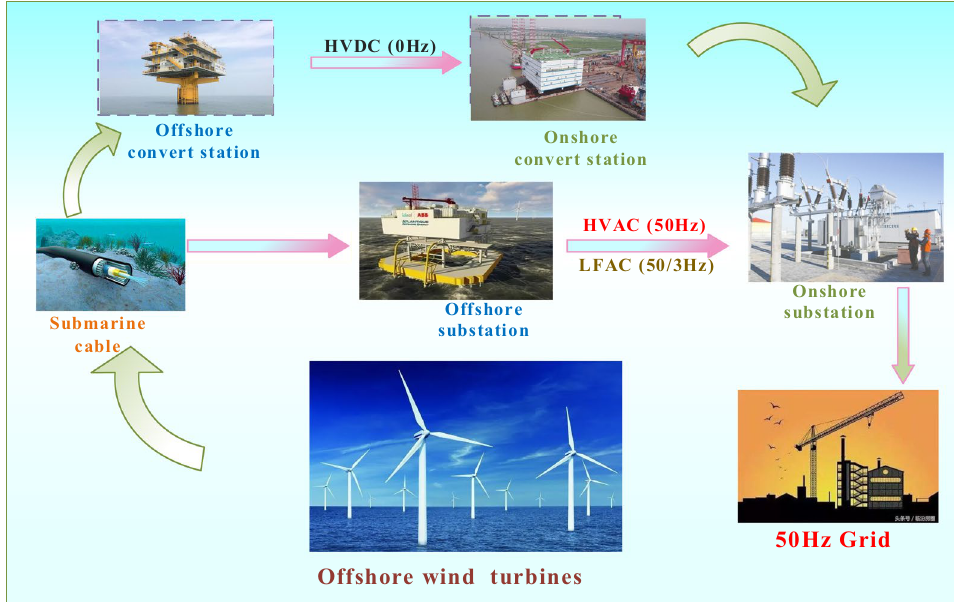
Fig. 1 Technologies of OWF